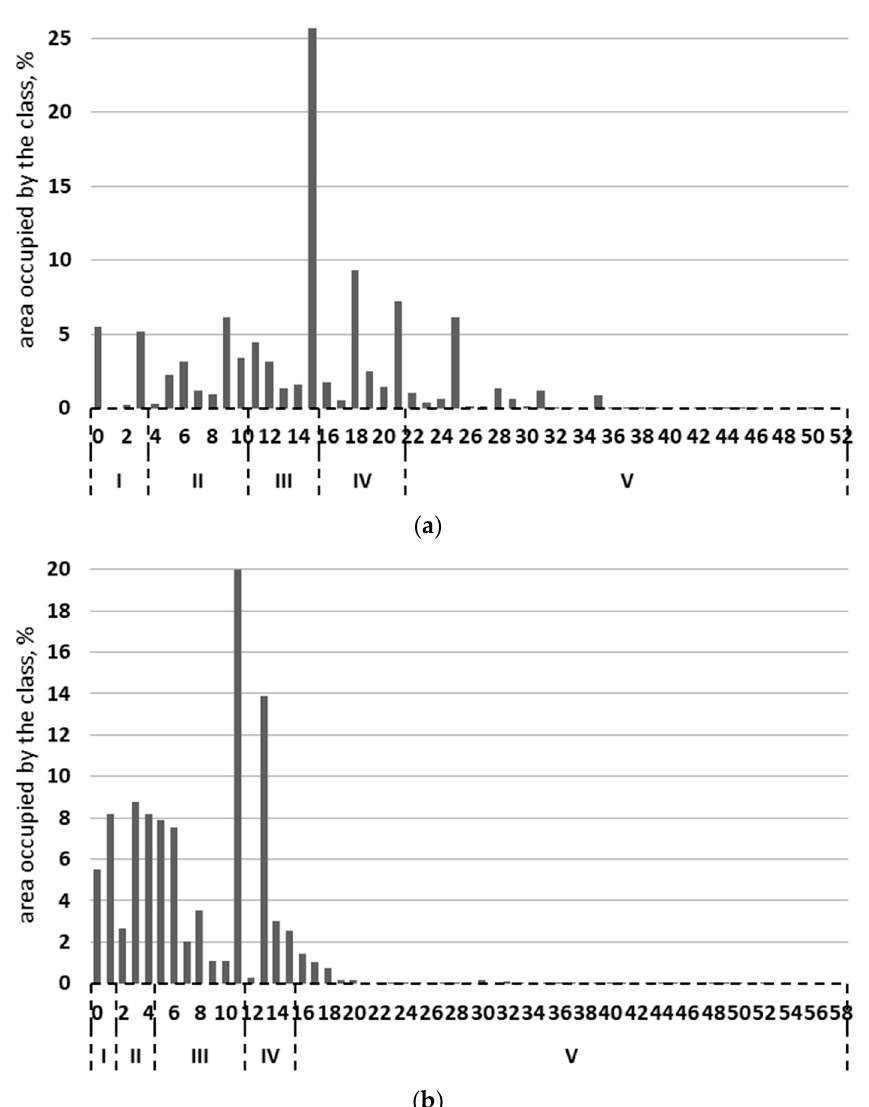
Figure 4. The category division in ( a ) the environmental, and ( b ) the social model, where on the x -axis Roman numbers I–V define classes of accessibility and Arabic numbers-gridcode.